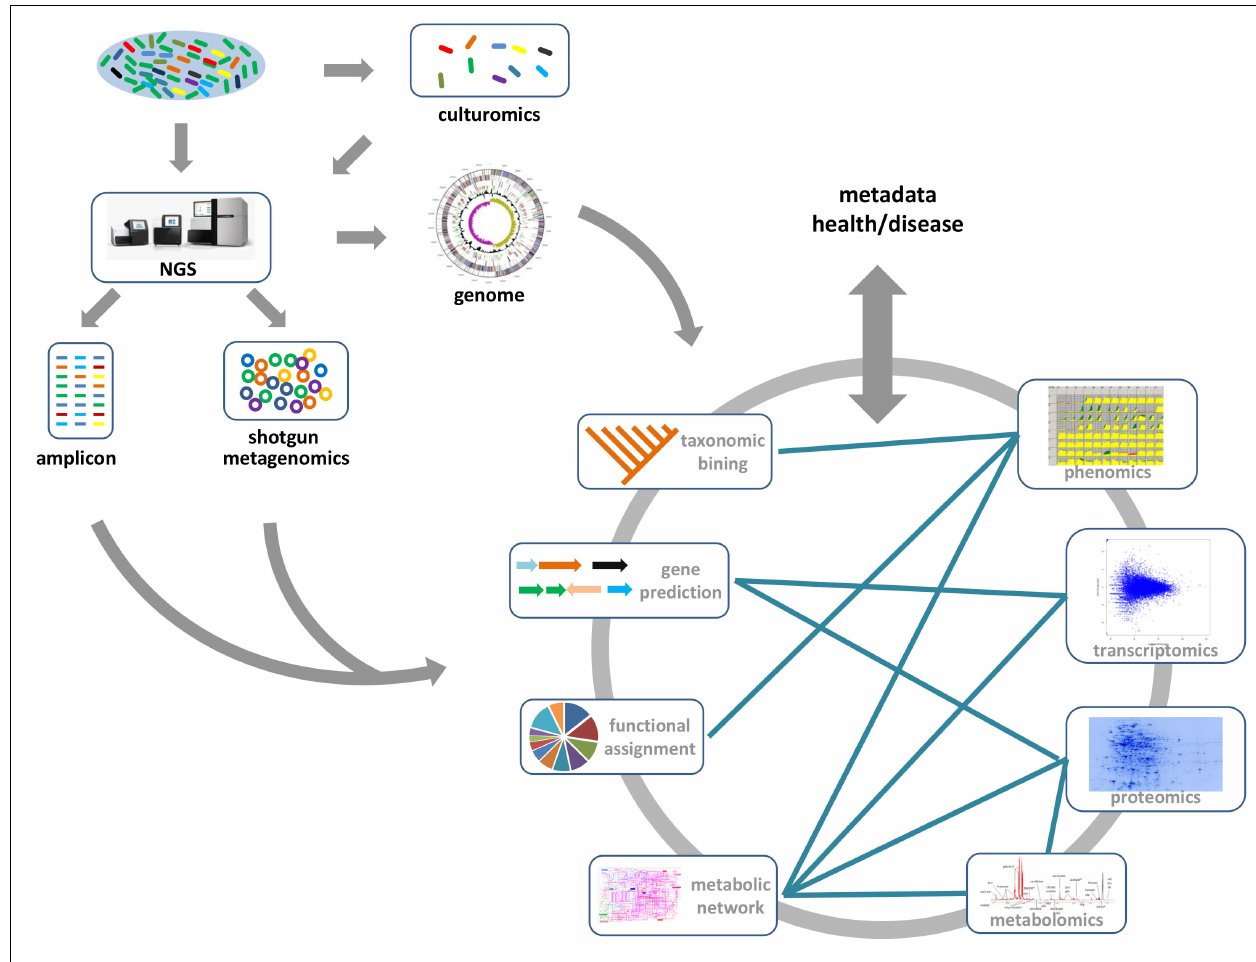
FIGURE 1 | The gene/genome-centric approach for the gut microbiome. Generally, 16S-rRNA based amplicon sequencing and whole shotgun sequencing are the two main metagenomic approaches for gut microbiome studies. From metagenome data, the taxonomic compositions and functional categories of the gut microbial communities, which may be associated with the health or disease state, can be inferred. Moreover, the combination of culturomics and NGS methods provides deeper information